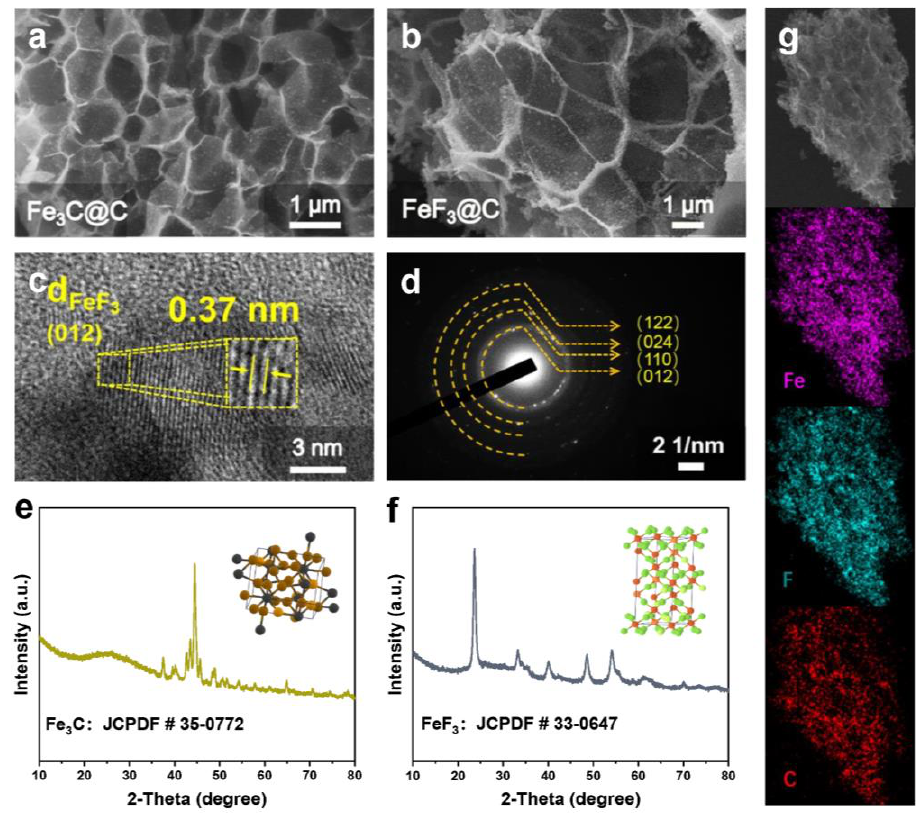
Figure 2. ( a ) FESEM of Fe 3 C@C and ( b ) FeF 3 @C, ( c ) HRTEM image and ( d ) SAED pattern of FeF 3 @C, ( e ) XRD pattern of Fe 3 C@C and ( f ) FeF 3 @C, ( g ) EDS mapping images of FeF 3 @C.